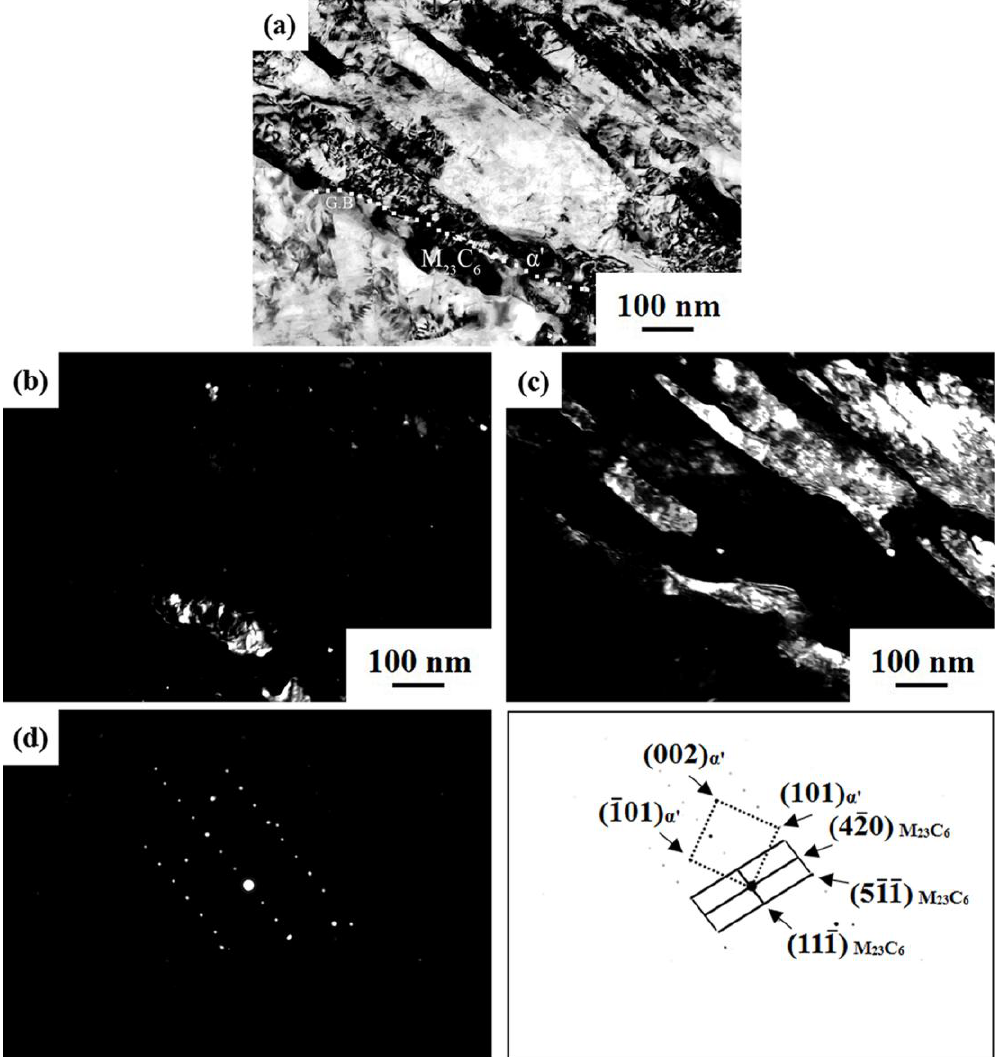
Figure 7. TEM images of the CR-450 specimen: ( a ) bright field image, ( b ) dark field image of carbides using (11 1 ) diffraction spot, ( c ) dark field image of α′ martensite using ( 1 01) spot, ( d ) selected area diffraction pattern with two identified structures.